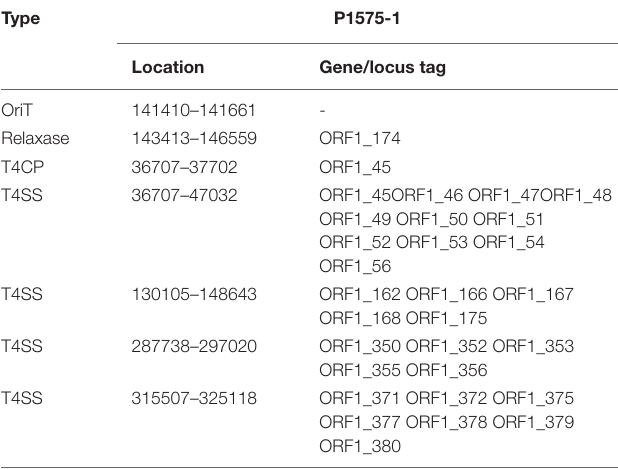
TABLE 4 | Type IV secretion system